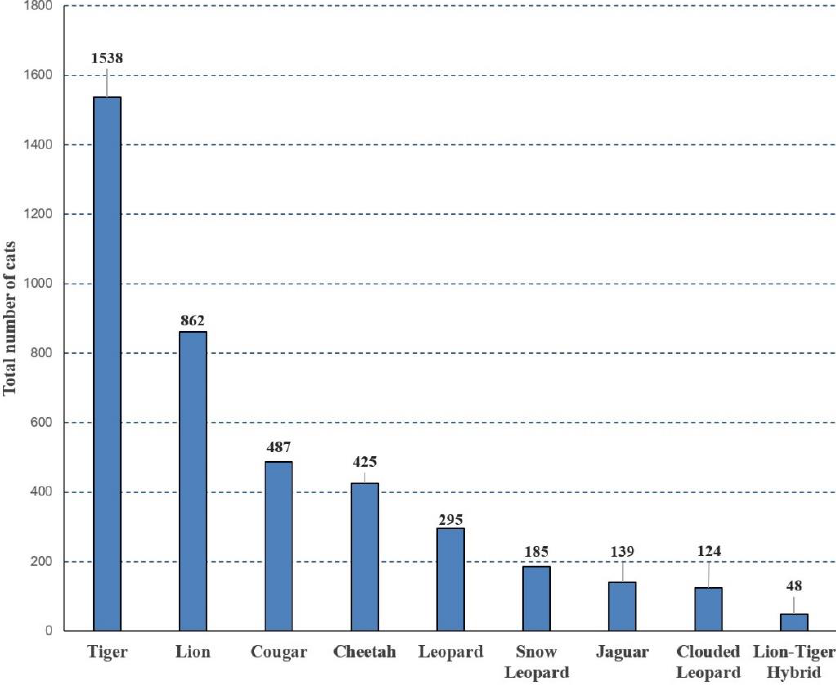
Figure 3. Total population of each big cat species within all federally regulated facilities.